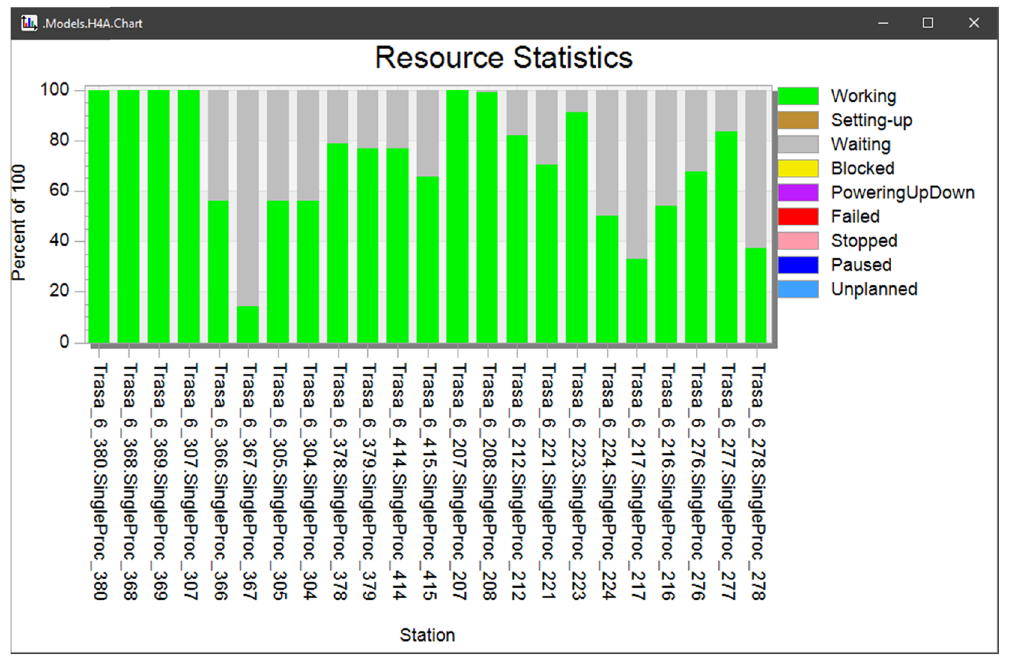
Figure 9: Histogram when supplying the line with two robotic AGV